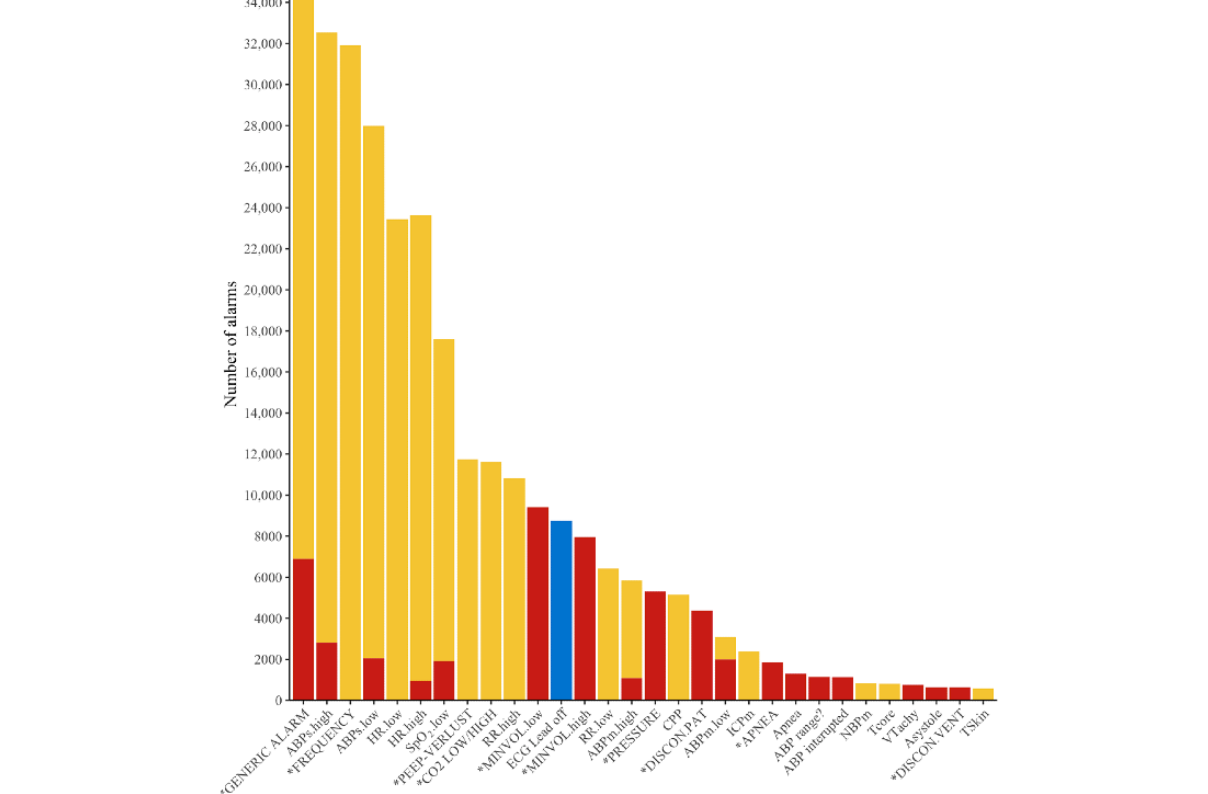
Figure 2. Frequency of individual alarm parameters within 93 days. The colors correspond to the alarm criticalities (red, yellow, and blue). *: ventilator arm; ABPs: systolic arterial blood pressure; ECG: electrocardiogram; FREQUENCY: ventilator alarm indicating that the upper respiratory rate threshold has been exceeded; HR: heart rate; RR: respiratory rate derived from the ECG (see Multimedia Appendix 2 for all